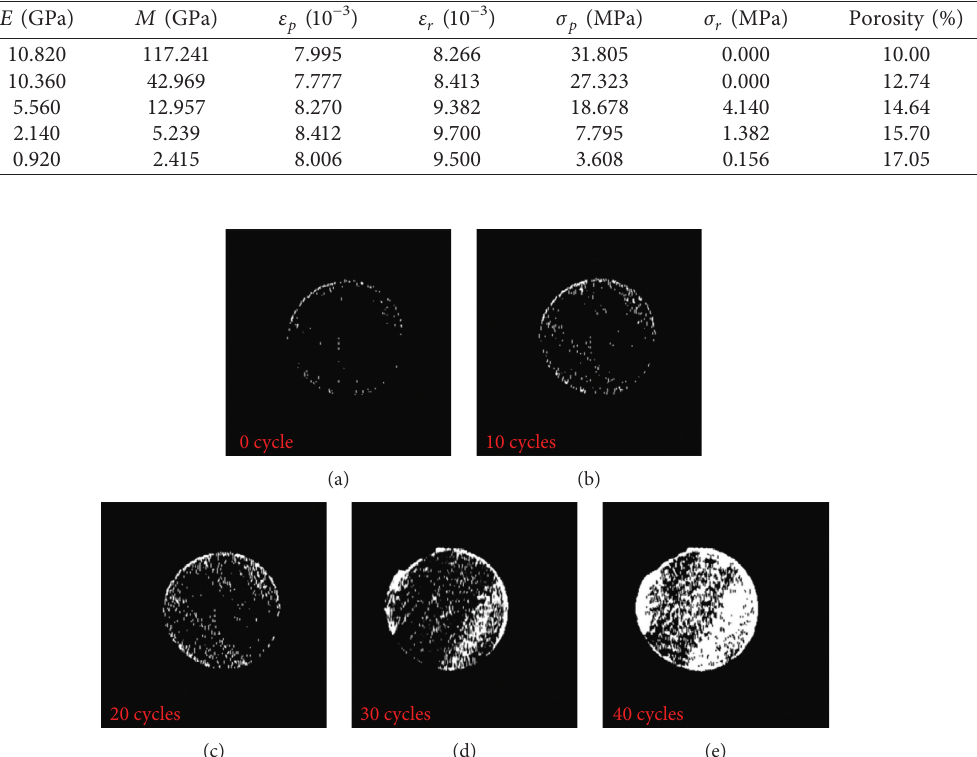
Figure 13: Evaluation of the microstructure inside the sandstone after various F-T cycles in view of MRI.